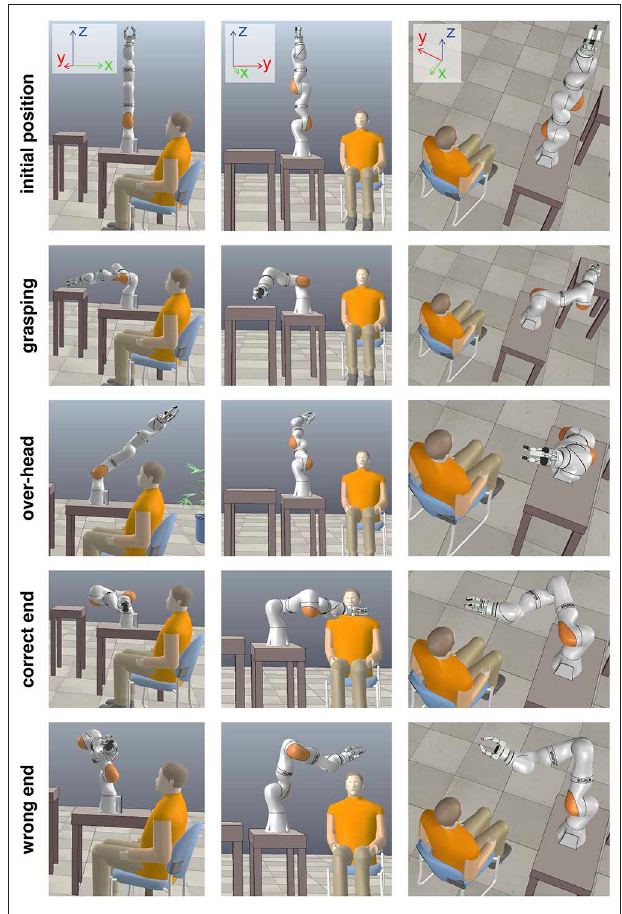
FIGURE 4 | Key robot poses during the human-robot interaction. In addition to the initial pose, four key poses were pre-programmed into the trajectories. The object-grasping pose, a pose above the user’s head and outside of its field of view, the correct end pose where the grasped object is delivered to the user, and the wrong end pose where the grasped object cannot be properly delivered to the user. Screenshots from the V-REP reconstruction.